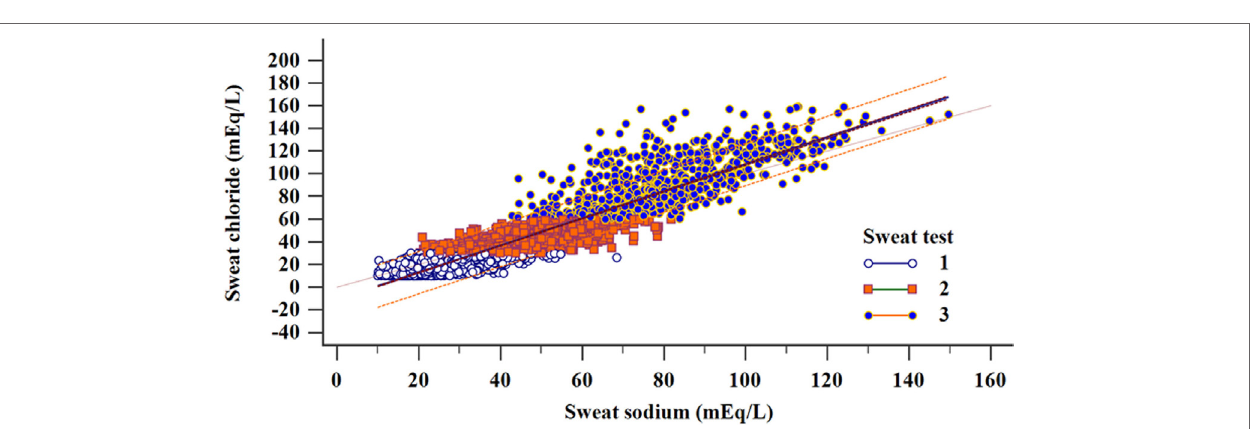
FigUre 3 | Distribution of sex of subject, considering sweat chloride (mEq/L) and sweat weight. (a) Sweat weight (mg). (chloride < 30 mEq/L) Female: N = 1,415; mean of 171 ± 43; median of 167 (amplitude from 75 to 337); male: N = 1,821; mean of 178 ± 43; median of 175 (amplitude from 76 to 367) ( p < 0.001); (chloride ≥ 30 to < 60 mEq/L) female: N = 691; mean of 156 ± 38; median of 149 (amplitude from 87 to 279); male: N = 633; mean of 168 ± 44; median of 162 (amplitude from 78 a 299) ( p < 0.001); (chloride ≥ 60 mEq/L) Female: N = 370; mean of 157 ± 39; median of 150 (amplitude from 78 to 295); male: N = 332; mean of 170 ± 44; median of 168 (amplitude from 79 to 326) ( p < 0.001). (b) Sweat chloride concentrations obtained in the sweat test. ( < 30 mEq/L) Female: N = 1,821; mean of 18.15 ± 5.26; median of 17.4 (amplitude from 10 to 29.9); male: N = 1,415; mean of 18.54 ± 5.29; median of 17.7 (amplitude from 10 to 29.9) ( p = 0.038); (chloride ≥ 30 to < 60 mEq/L) female: N = 691; mean of 42.08 ± 8.29; median of 41.1 (amplitude from 30 to 59.8); male: N = 633; mean of 40.89 ± 8.28; median of 39.3 (amplitude from 30 to 59.9) ( p = 0.006); (chloride ≥ 60 mEq/L) female: N = 370; mean of 91.87 ± 24.53; median of 86.85 (amplitude from 60 to 158.6); male: N = 332; mean of 93.28 ± 25.06; median of 91.2 (amplitude from 60 to 159.2) ( p = 0.618). The statistical analysis was performed by Mann–Whitney test. α = 0.05. The median is set in red marker and the 95% confidence interval is set in green line. The second graphic is a box plot. mEq/L, milliequivalents per liter.